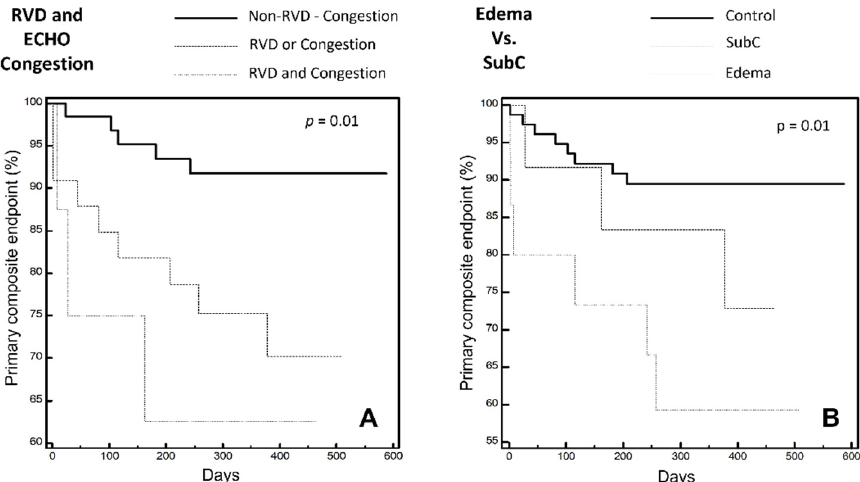
Figure 3. Primary composite endpoint expressed by Kaplan-Meier curves: ( A ) combining tertiles of the right ventricular dysfunction and estimated right atrial pressure. ( B ) in the three main groups: “Control”; “SubC”; “Edema”. RVD: Right Ventricular Dysfunction. SubC: Sub Clinical Congestion. ECHO Congestion: RAP ≥ 13 mmHg according to IVC diameter and collapse ratio.